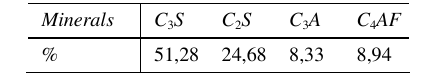
Table 2. Mineralogical composition of the clinker (Bogue) Minerals